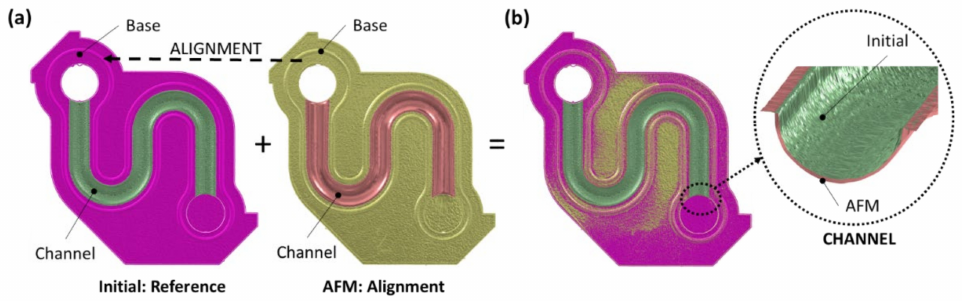
Figure 5. S-shape, STL alignment: ( a ) alignment procedure; ( b ) STL AFM to STL initial result. Ra measurements, V-shape: To establish the Ra ( MR t ) function, the same reference planes as for the MR v measurement were used (Figure 4a). However, for this study, 8 × 8 mm segments with a relatively uniform MR t evolution on each of the surfaces ( MR t,n ) were selected, as shown in Figure 6a. Next, the “Multiline roughness” module of the 3D microscope with 30 equally spaced (~250 µ m) lines was used to calculate the average Ra (Figure 6b). The MR t,n was found as defined by Equation (13):